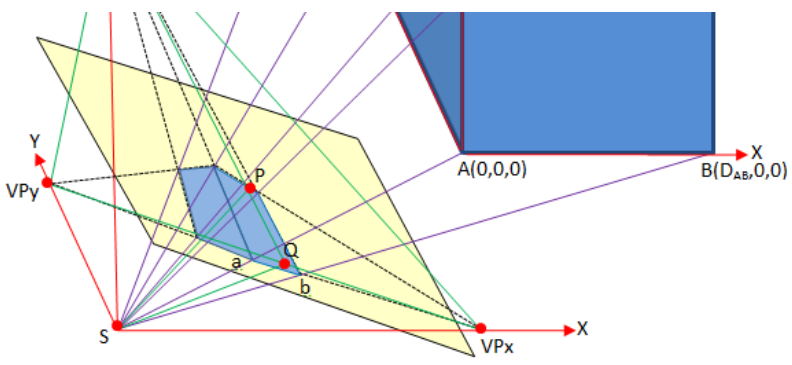
Figure 7. The coordinates of the point of view, S , can be computed once the principal point ( P ), focal length ( f ), and rotation angles ( θ , ν , χ ) are known by proceeding to a Datum definition by which two imaged points ( a and b ) receive two object coordinates: A (0,0,0) and B ( D ,0,0) and by means of the collinearity equations. In this case, the X coordinate of AB point B , that lies on X axis, is the measured distance between A and B .